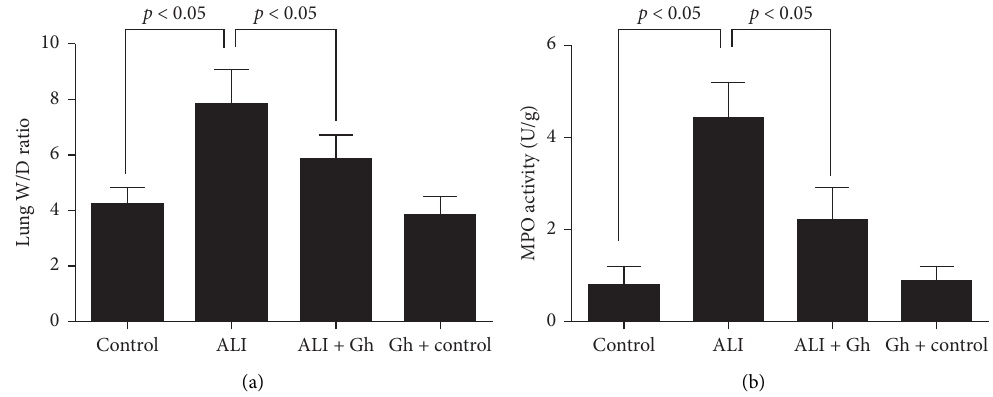
Figure 4: Ghrelin pretreatment reduced the wet-to-dry (W/D) lung weight ratio and the MPO activity in the LPS-induced ALI rats. (a) The W/D lung ratio and (b) the MPO activity were determined at 4 h after the LPS administration. Data are presented as the mean ± SD ( n � 3).